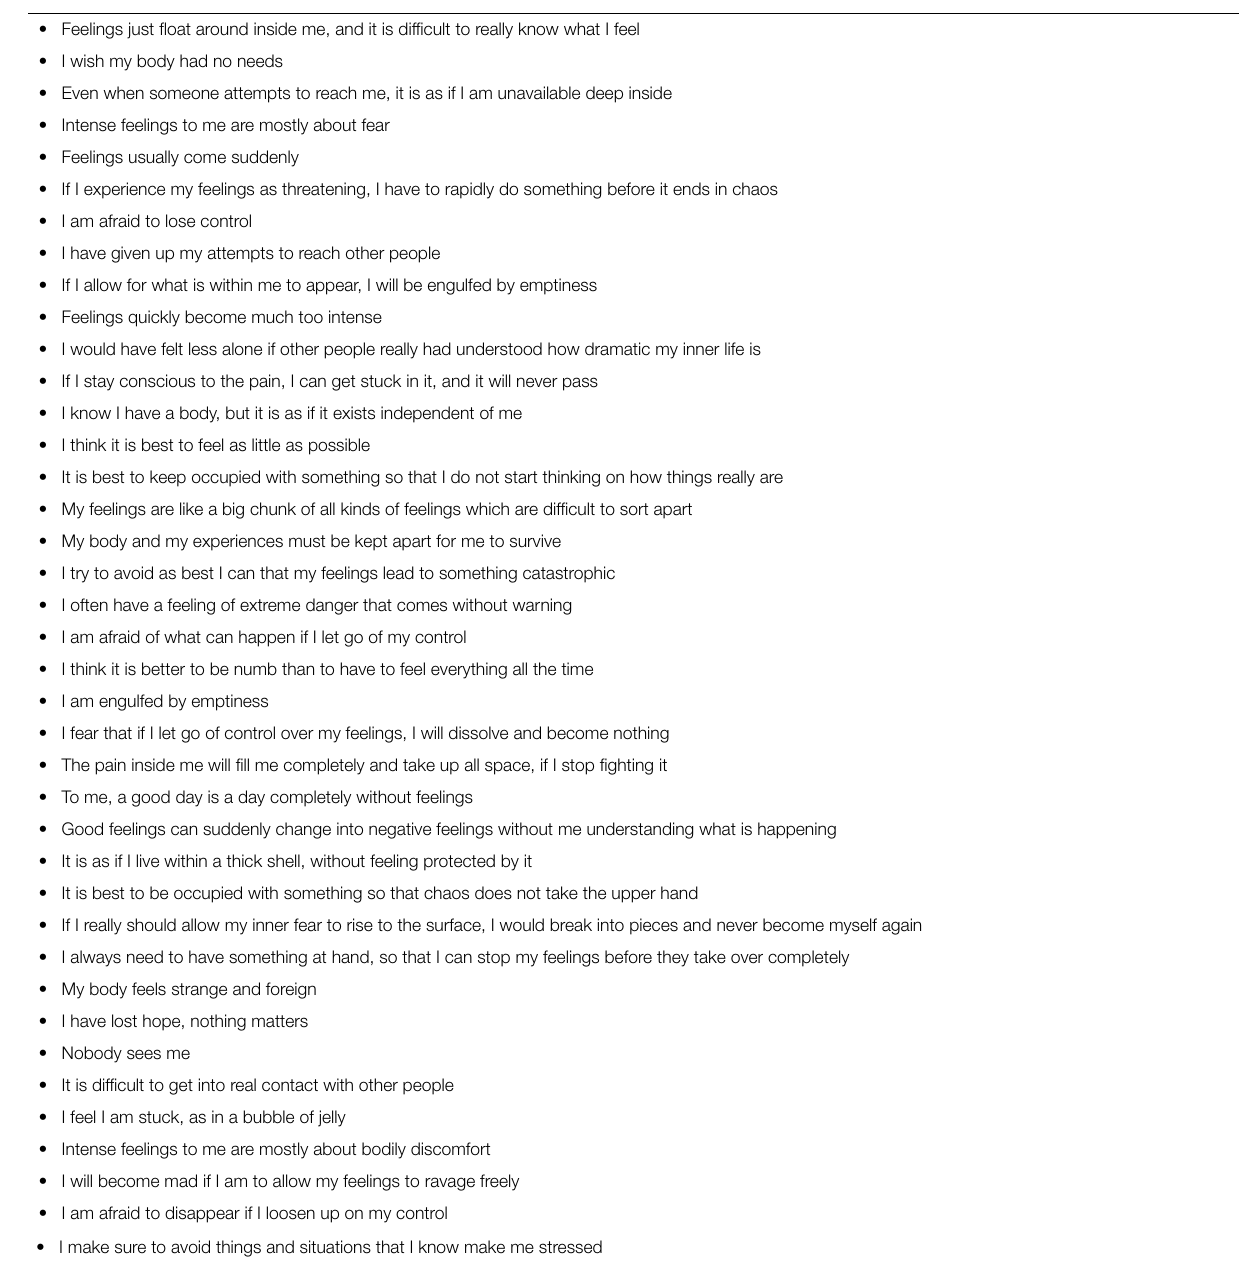
TABLE 1 | Expressions that reflect catastrophic feelings or maneuvers to avoid